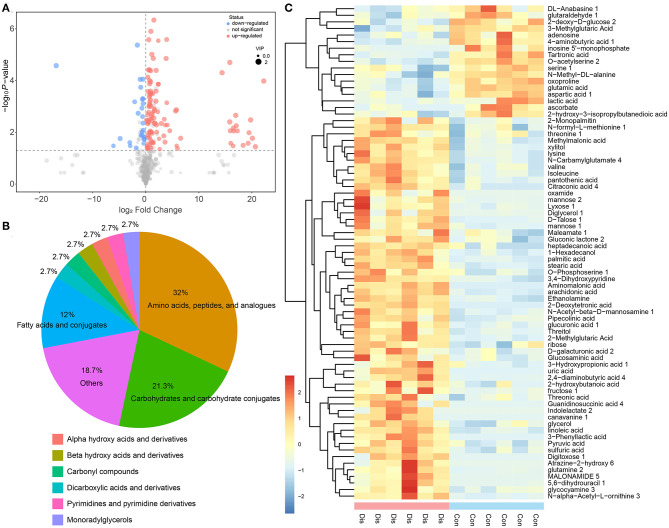
The profile of discrepant metabolites obtained from the OPLS-DA model of the Dis vs. Con group by the selected rule (VIP >1 and P < 0.05). (A) Volcano plot of differential metabolites in the Dis group compared with the Con group; each point in the volcanic plot represents a metabolite and the size of the point showing the value of the VIP. (B) The category of the differential metabolites. (C) The heat map representation of unsupervised hierarchical clustering applied in differential metabolites.